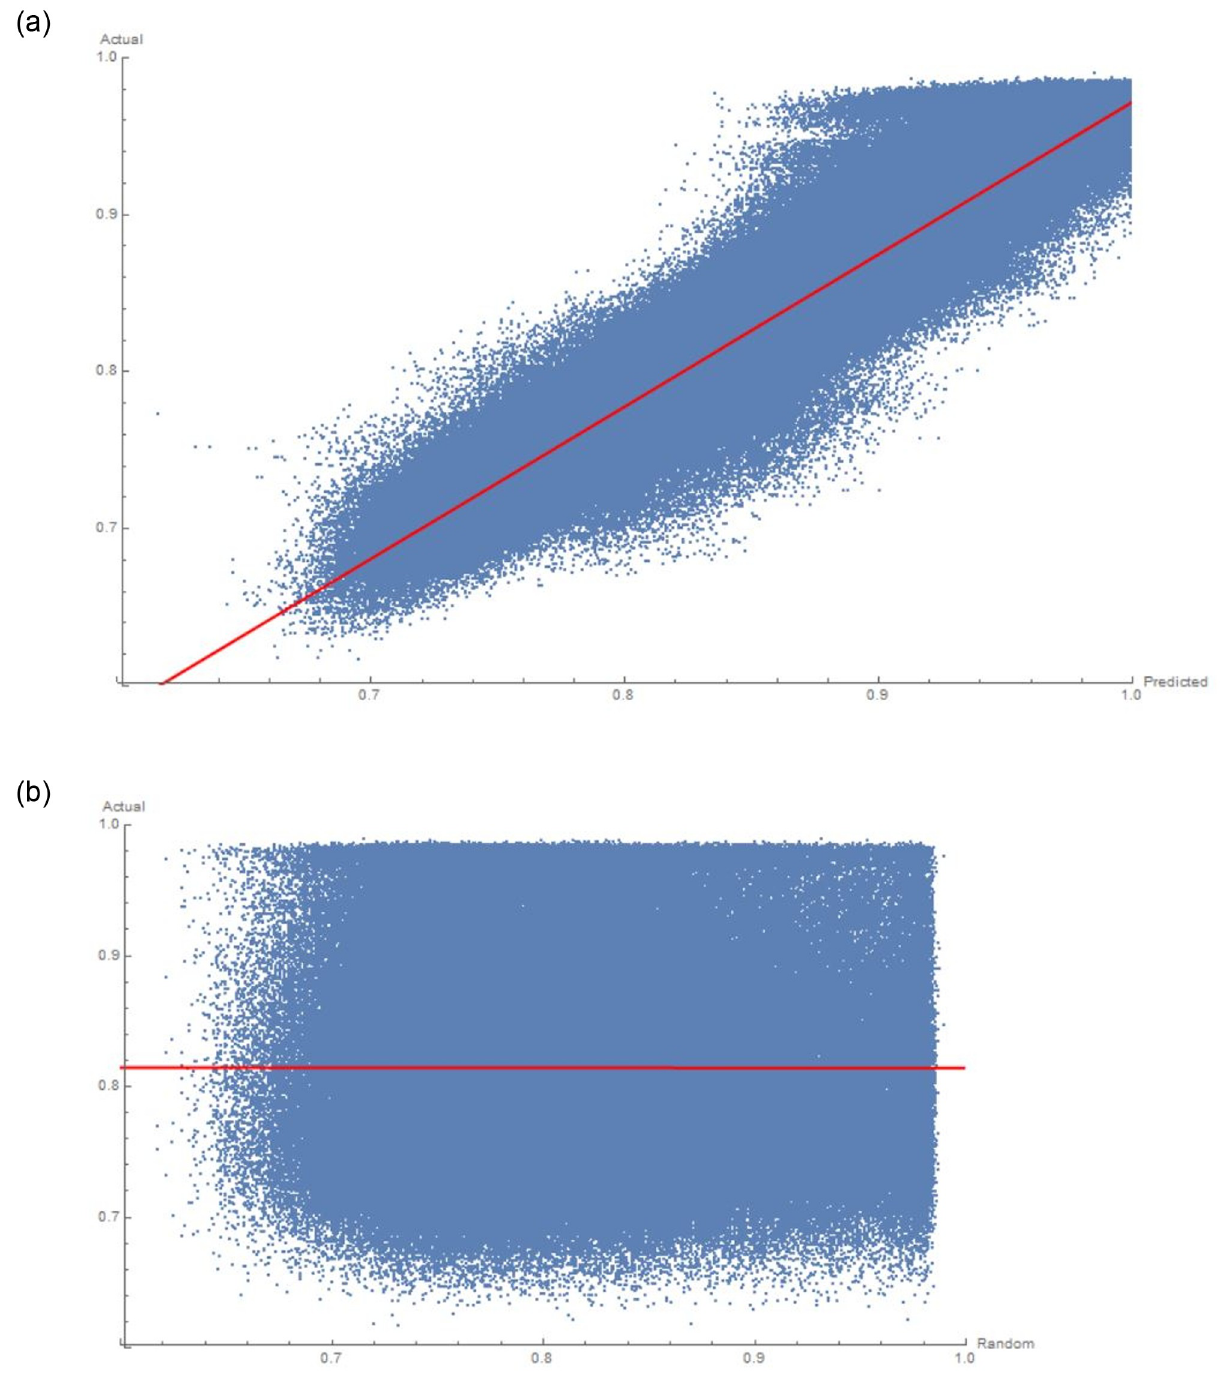
Fig 3. A A scatter plot of the predicted and actual value of � for the validation data from a 30, 000 training sample; B scatter plot of a random-prediction versus the actual � value.